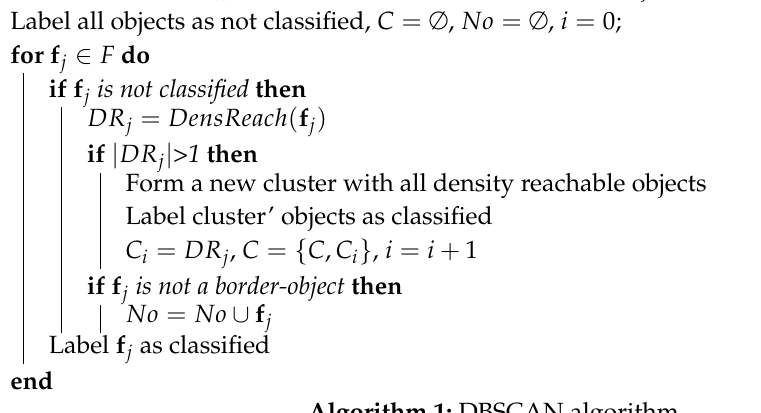
Algorithm 1: DBSCAN algorithm.